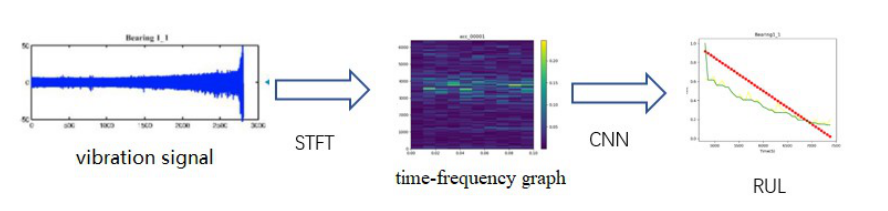
Figure 3. The flow diagram of our